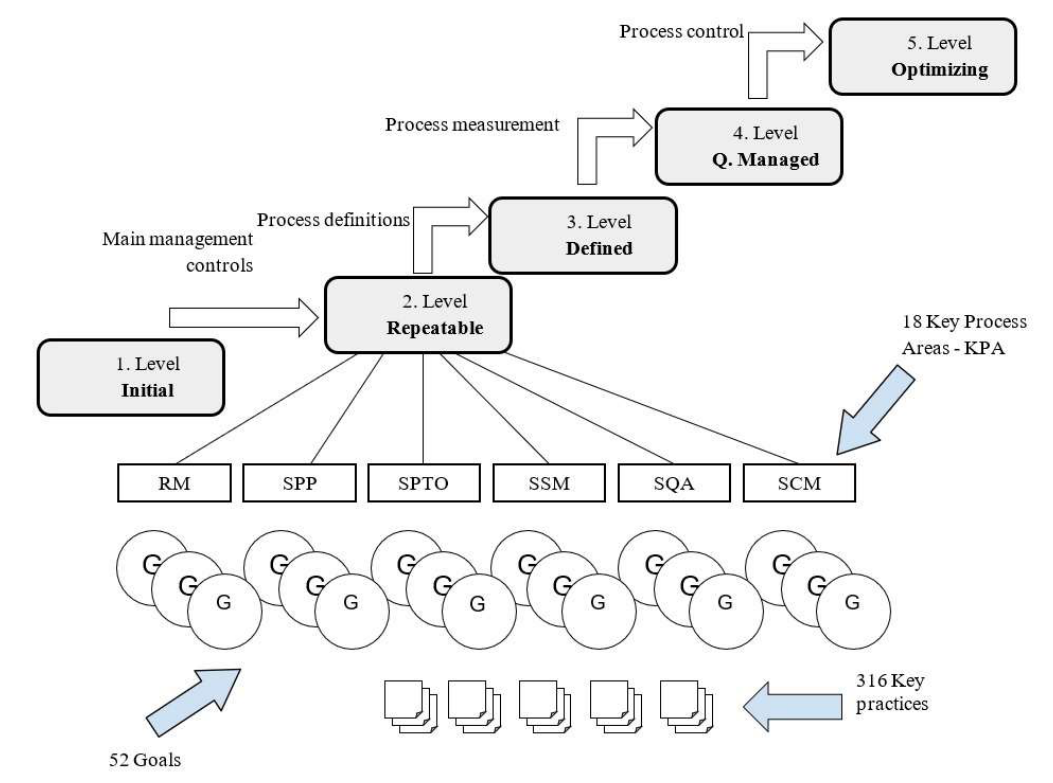
Figure 1. Hierarchical structure of the SW-CMM model